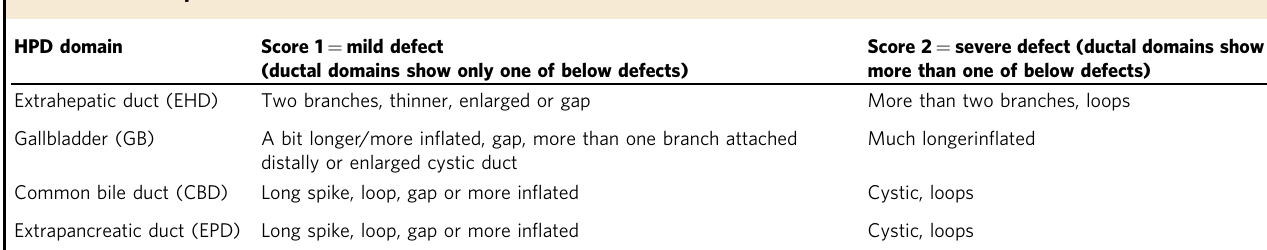
Table 1 Domain-speci fi c classi fi cation of HPD tube formation defects HPD